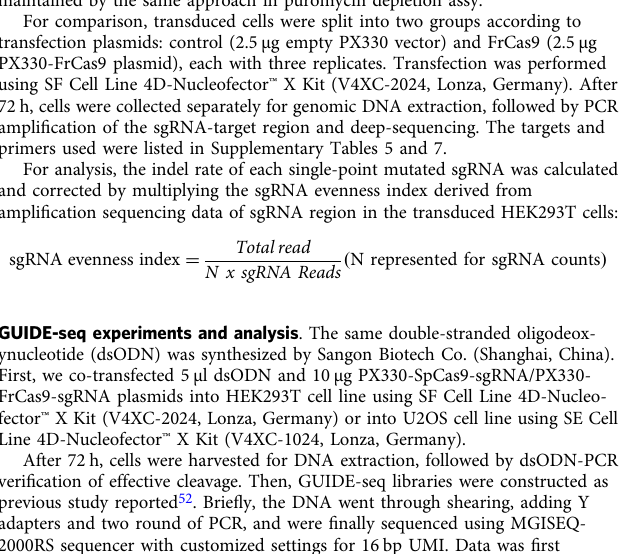
Fig. 5 The wide applications of FrCas9 due to its 5 ′ -NNTA-3 ′ PAM. a The veen diagram of pathogenic mutations in ClinVar database that could be corrected by SpCas9 and FrCas9 base editors. b The C > T transition ef fi ciencies of FrCas9-BE4Gam using 2 “ back-to-back ” sgRNA at the same time. The TA-3 ′ (represented for FrCas9 PAM) distribution in the GRCh38 human genome. e The schematics of FrCas9 targeting TATA-boxes of ABCA1 gene.